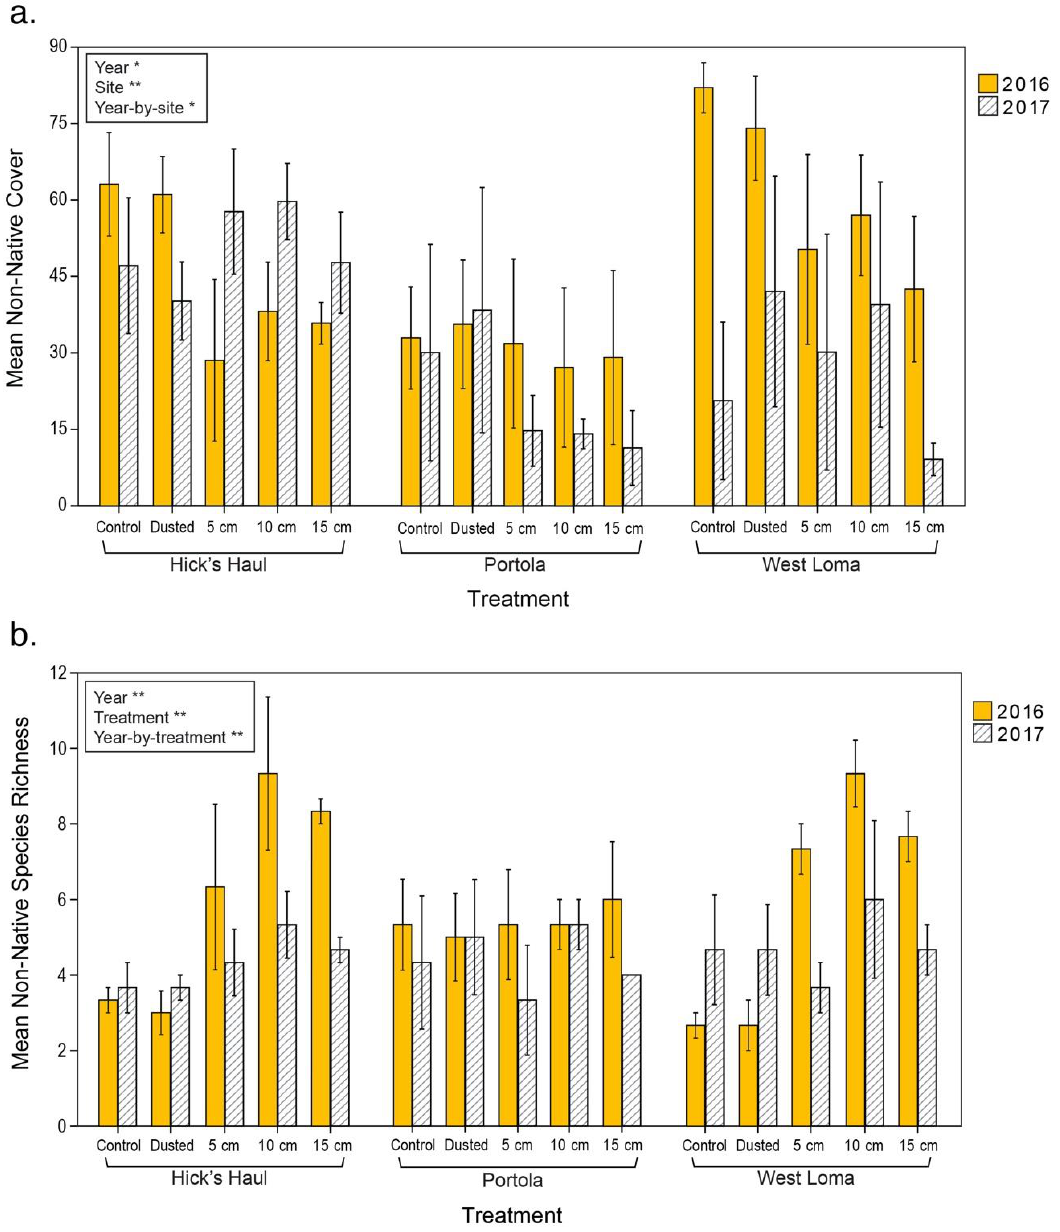
Figure 6. Mean non-native cover ( a ) and mean non-native species richness ( b ) by treatment at the donor sites. Bars represent +/ − 1SE of the mean (repeated measures ANOVA *** p < 0.0001, ** p < 0.01, * p < 0.05).